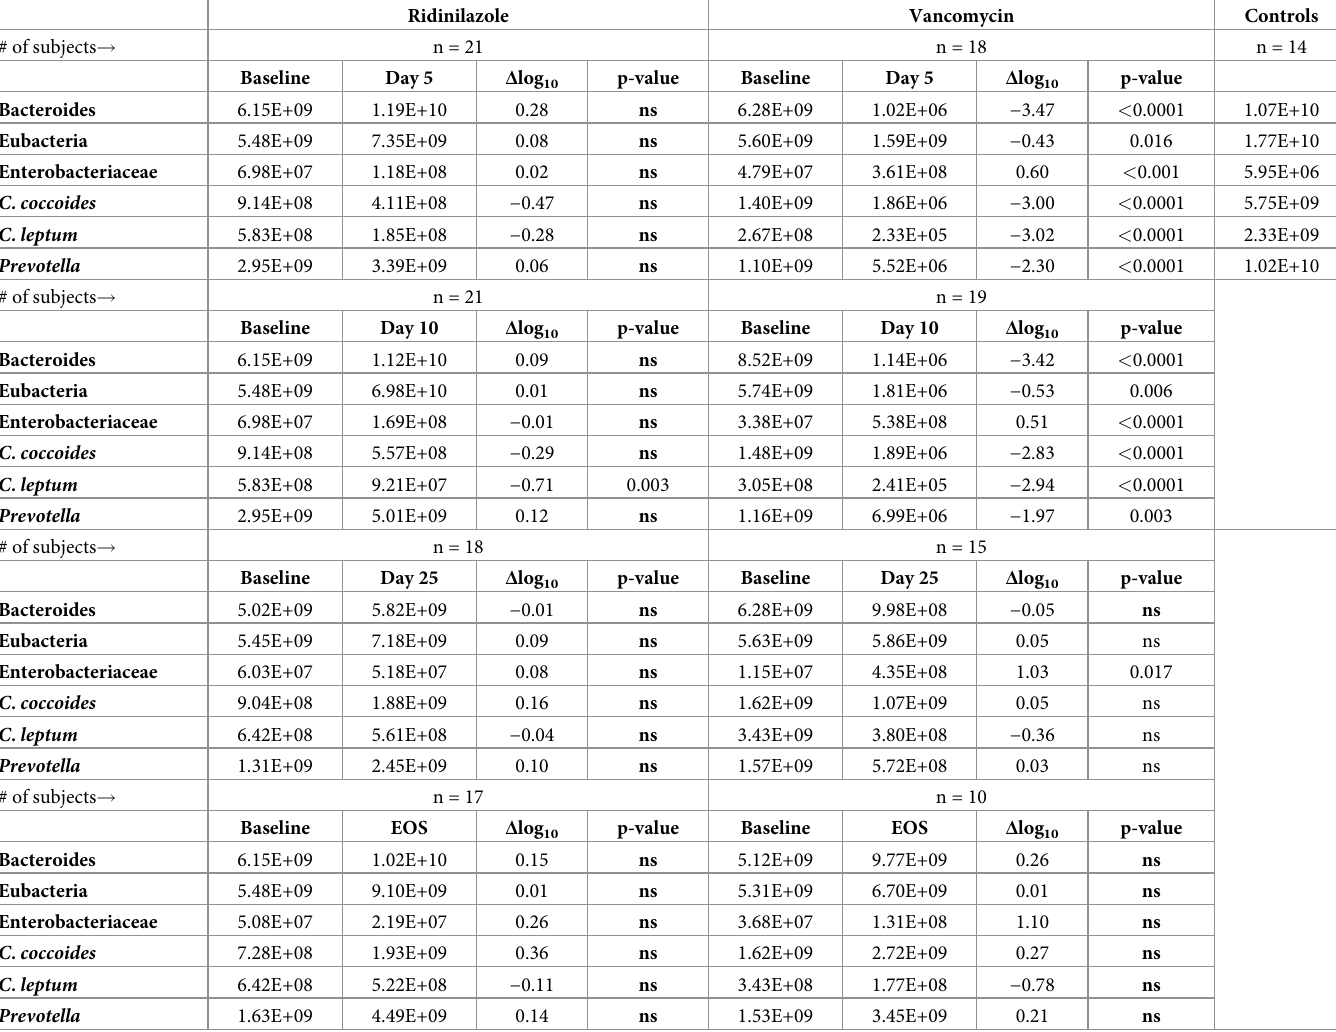
Table 1. Comparison of bacterial group median quantities at each timepoint within treatment